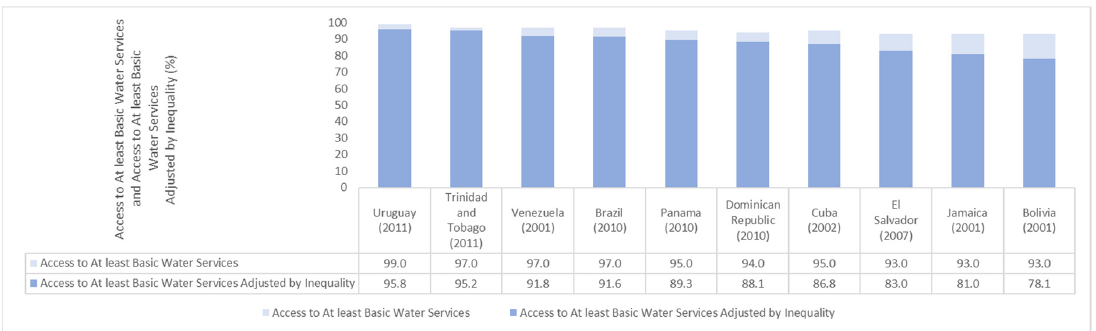
Figure 4. Access to at least basic water services and access to at least basic water services adjusted by inequality. Source: Own elaboration based on census microdata from the IPUMS- International Project [25].